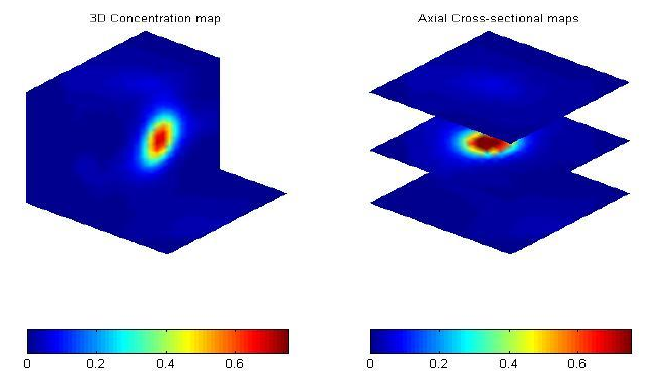
Figure 14. Snapshot of a ball falling in Paratherm fluid by